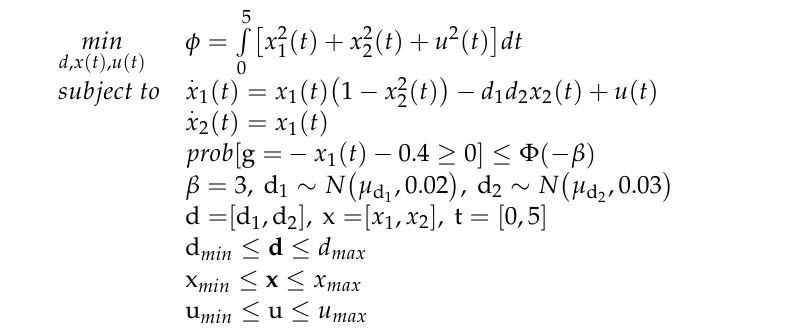
Table 1. The information of the design, state, and control variable of test 4.1.